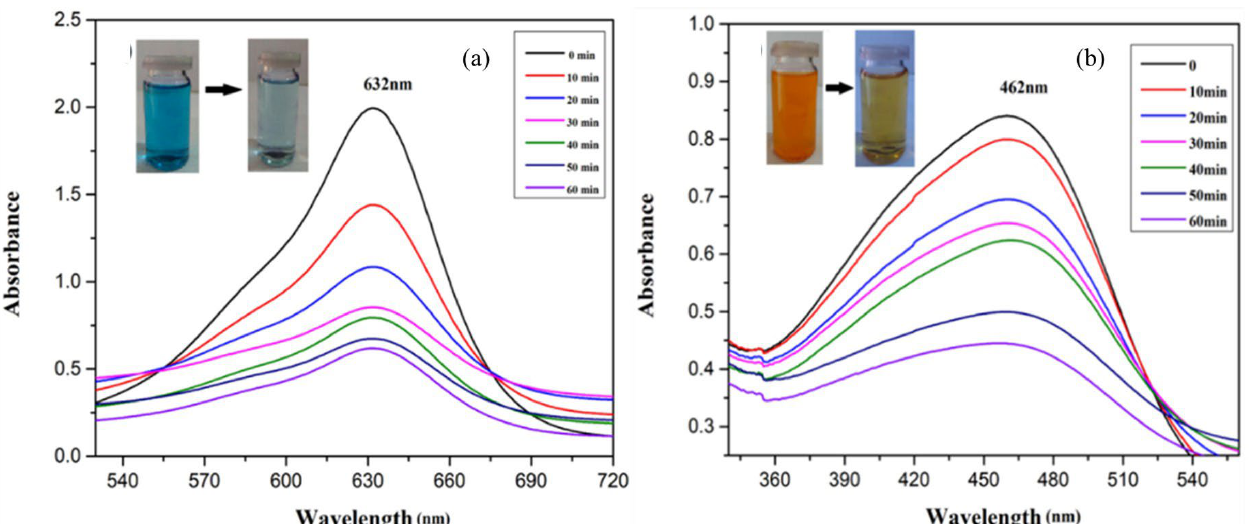
Figure 7. Absorption spectra of the dyes at different time intervals: ( a ) MG, ( b ) MO.